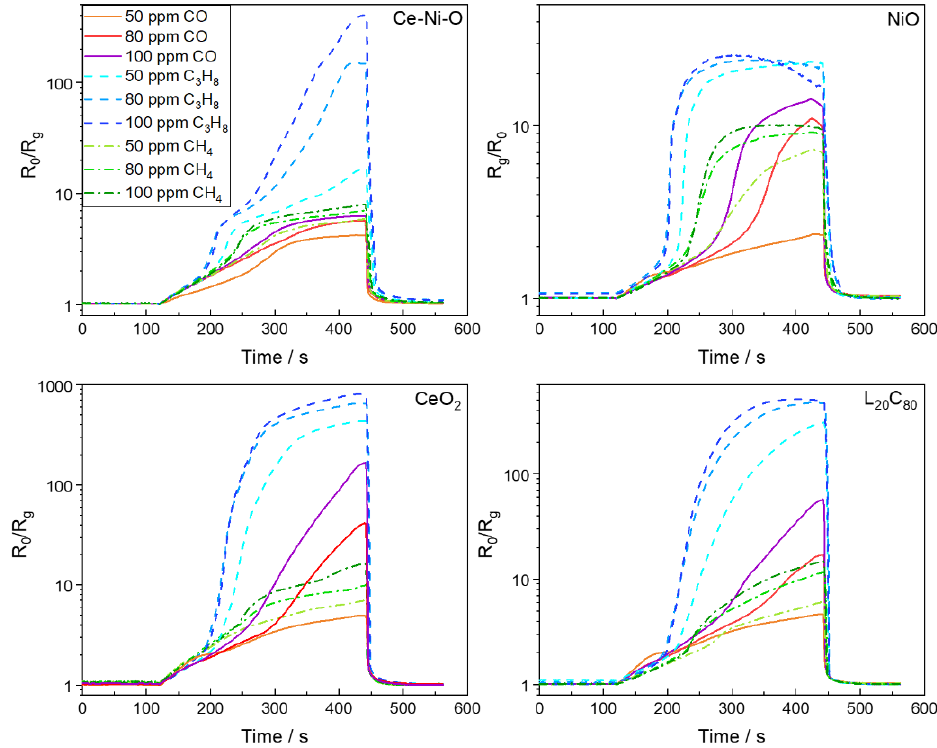
Figure 1. Real-time sensing performance of the sensor array.